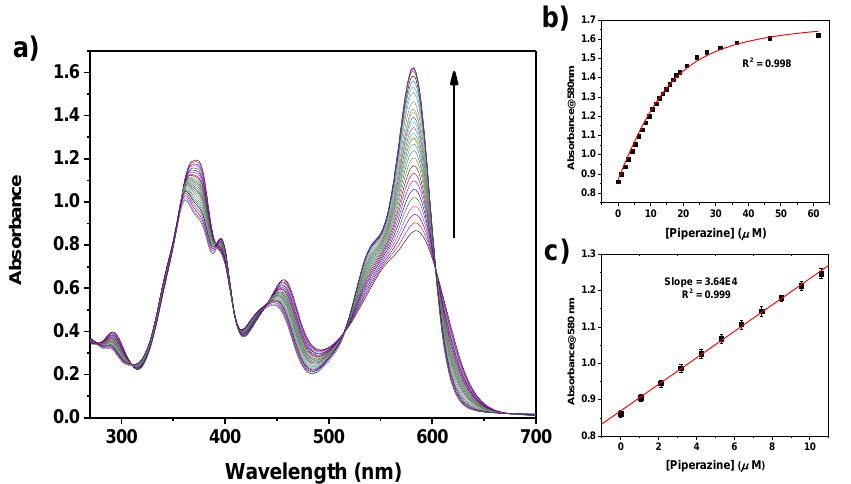
Figure 6. ( a ) Optical absorption titration curves of 1 (15 µM solution in CHCl 3 ) with addition of PZ. The concentration of PZ added varied from 0 to 60 µM. ( b ) Variation of the absorbance at 580 nm as a function of the concentration of PZ added and fit of the binding isotherm with Equation (1) (red line). ( c ) Linear best fit in the linear dynamic range (weight given by data error bars).